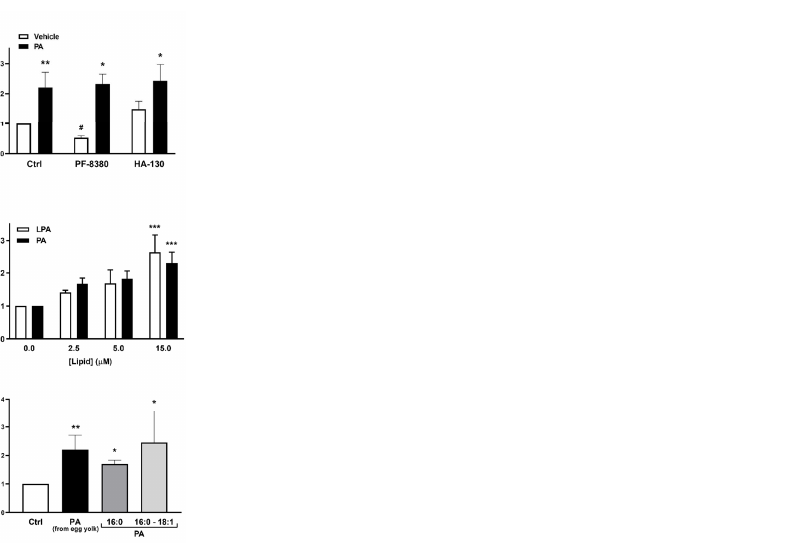
Figure 8. PA-stimulated myoblast proliferation does not depend on conversion of PA to LPA. Myoblasts were serum-starved in DMEM supplemented with 0.1% BSA for 24 h. ( A ) The cells were preincubated with 20 µ M PACOCF3, 20 µ M AACOCF3 or with 1 µ M of the cPLA 2 α inhibitor pyrrophenone (N-{(2S,4R)-4-(Biphenyl-2-ylmethyl-isobutyl-amino)-1-[2- (2,4-difluorobenzoyl)-benzoyl]-pyrrolidin-2-ylmethyl}-3-[4-(2,4-dioxothiazolidin-5-ylidenemethyl)-phenyl] acrylamide) for 30 min before they were challenged with 15 µ M PA for 16 h. [ 3 H]Thymidine incorporation into DNA was measured as described in the Materials and Methods section. Results are expressed relative to the control value without agonist and are the mean ± SEM of 3 independent experiments performed in triplicate (** p < 0.01, control versus PA-treated cells; * p < 0.05, control versus PA-treated cells in the presence of the indicated inhibitors. ( B ) Cells were treated as in panel A. Cell proliferation was determined by staining the myoblasts with crystal violet as described in the Materials and Methods section. Results are expressed relative to the control value without agonist and are the mean ± SEM of 3 independent experiments performed in triplicate. (* p < 0.05, control versus PA-treated cells in the absence or in the presence of the indicated inhibitors). ( C ) Cells were labelled with 15 µ M [ 14 C]PA (0.05 µ Ci/mL) for the indicated time points. PA and LPA levels were determined as described in the Materials and Methods section. Results are expressed as percentage of the radioactivity present in the PA and LPA thin-layer chromatography (TLC) spots compared to that in total lipids and are the mean ± SEM of 3 independent experiments performed in duplicate. ( D ) The cells were preincubated with 300 nM HA-130 or 300 nM PF-8380 for 30 min before they were treated with 15 µ M PA for 16 h. Cell proliferation was determined by staining the myoblasts with crystal violet as described in the Materials and Methods section. Results are expressed relative to the control value without agonist and are the mean ± SEM of 3 independent experiments performed in triplicate. (** p < 0.01, control versus PA-treated cells; * p < 0.05, control versus PA-treated cells in the presence of HA-130, or PF-8380 treated cells versus PA-treated cells in the presence of this inhibitor; # p < 0.05, control versus cells incubated with PF-8380). ( E ) Cells were treated with PA or LPA for 16 h at the indicated concentrations. [ 3 H]Thymidine incorporation into DNA was measured as described in the Materials and Methods section. Data are expressed relative to the control value without agonist and are the means ± SEM of 3 independent experiments performed in triplicate (*** p < 0.001, control versus PA- or LPA-treated cells). ( F ) Cells treated with PA from egg yolk or with different PA species (at 15 µ M), as indicated. Results are expressed relative to the control value without agonist and are the mean ± SEM of 6 independent experiments performed in triplicate. (** p < 0.01, control versus PA from egg yolk; * p < 0.05, control versus 16:0-PA or 16:0-18:1-PA, as